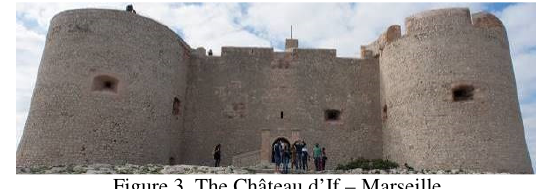
Figure 5. Models acquired in Milan: a) the polygonal tower of